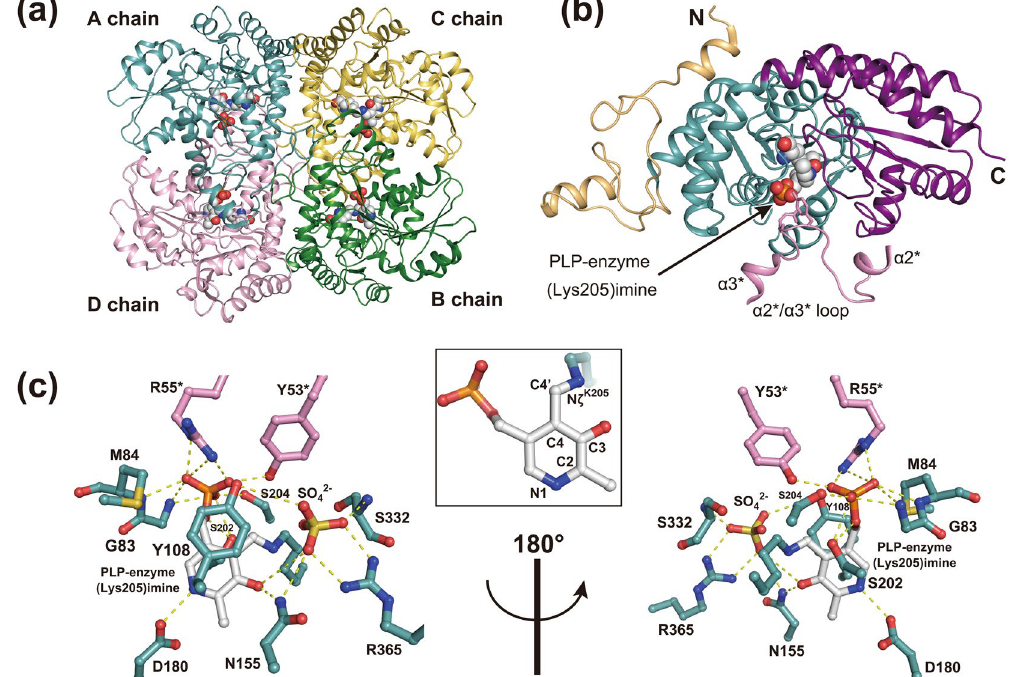
Figure 1. Structure of substrate-free EhMGL1. ( a ) Cartoon representation of the EhMGL1 homotetramer structure. A, B, C and D chains are colored in teal, deep green, yellow and pink, respectively. Two catalytic dimers are formed by A–D and B–C pairs. PLP-enzyme (Lys205) imine bound to each chain is shown as spheres with the color code C (white), N (blue), O (red) and P (orange). ( b ) Structure of the A chain. The N-terminal, PLP-binding and C-terminal domains are colored in light orange, teal and purple, respectively. The bound PLP- enzyme (Lys205) imine is shown as in ( a) . The α 2 * / α 3 * loop from the D chain is represented as a pink cartoon and contributes to the formation of the active site of the A chain. ( c ) Stick representation of the active site of the A chain. The color code of PLP-enzyme (Lys205) imine is the same as in ( a ). Residues from the PLP-binding domain are colored in teal, and residues from the α 2 * / α 3 * loop of the D chain are colored in pink. Dashed lines indicate hydrogen bonds. Numbering of the nitrogen and carbon atoms of PLP is shown in the inset. The images were generated using PyMOL 39